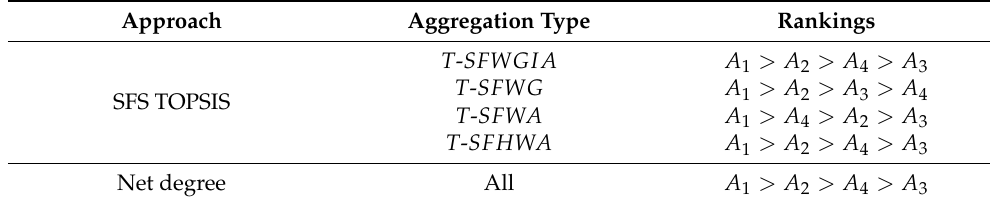
Table 3. Obtained rankings of A 1 – A 4 alternatives for the net degree method and SFS TOPSIS for the considered aggregation